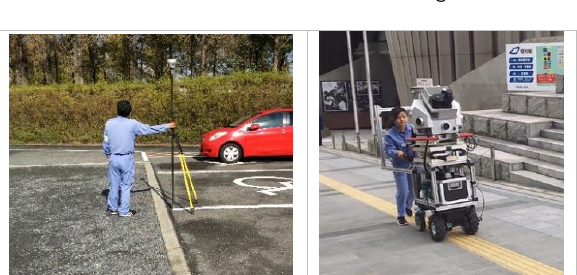
Figure 7. Typical check points (left) for evaluation of the developed trolley-loading system (right)